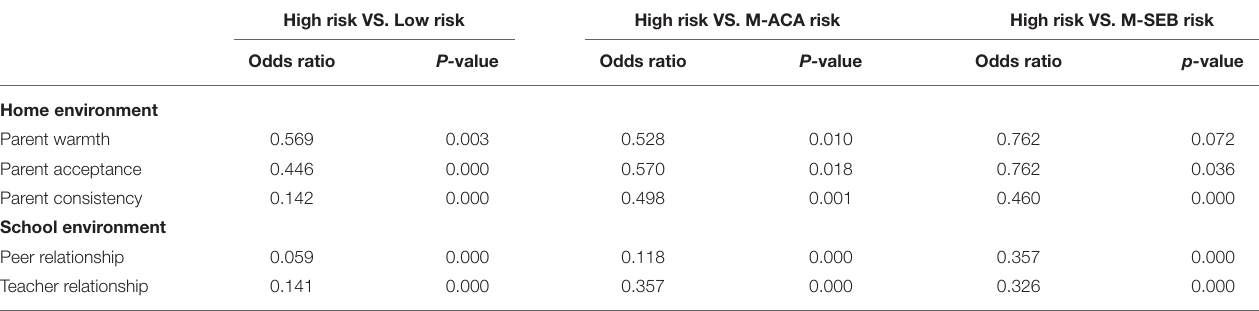
TABLE 6 | Tests of multinomial logistic regressions using the three-step